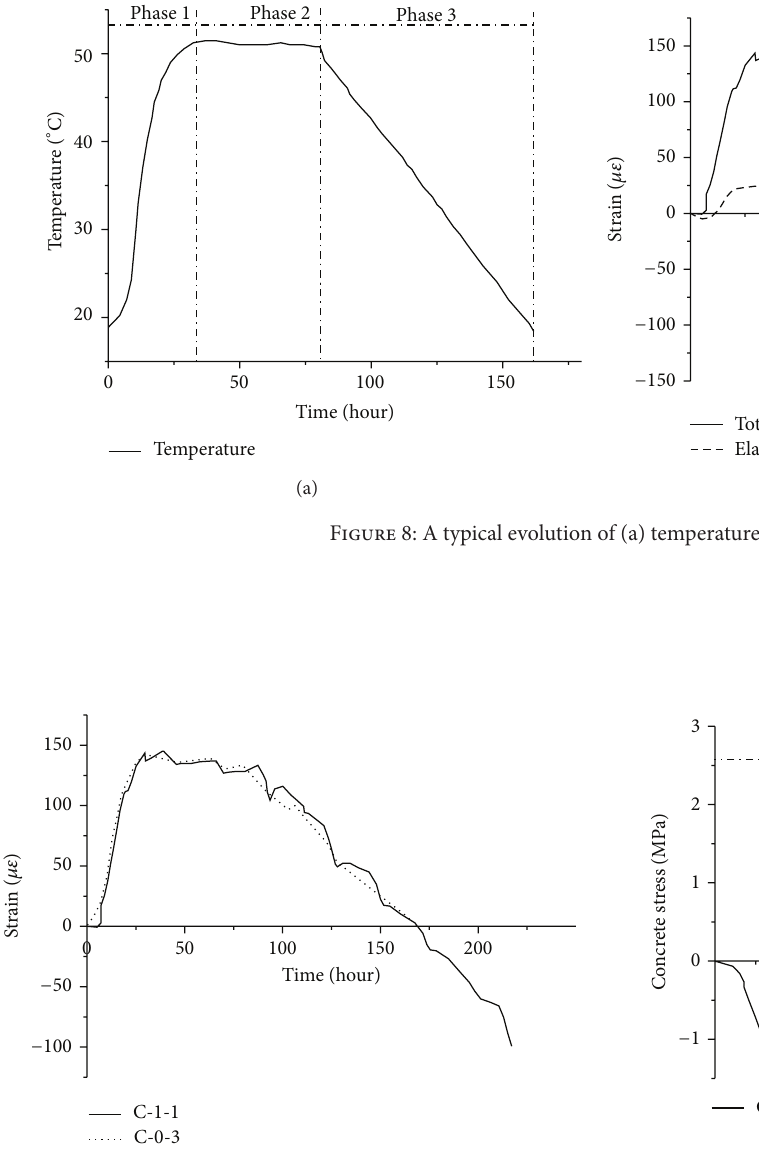
Figure 9: Free strain evolution of C-0-3 and C-1-1.